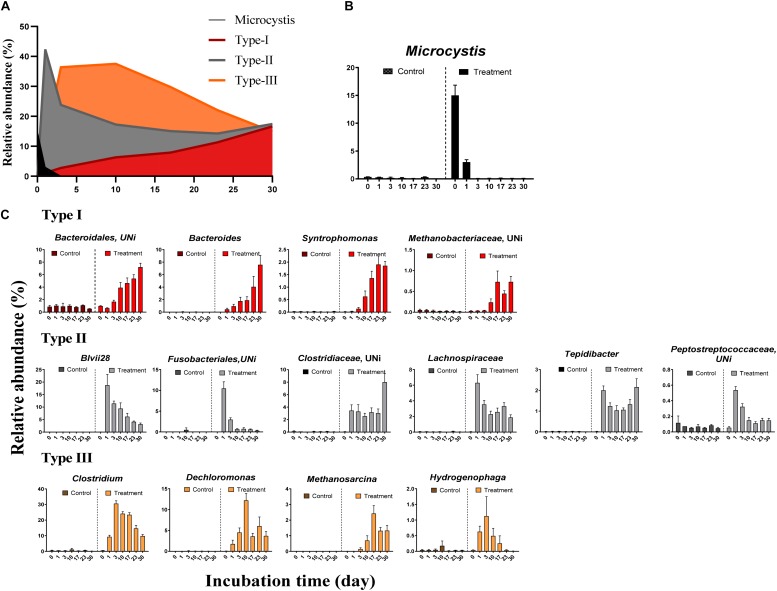
The relative abundance of Microcystis and three distinct microbial groups during the incubation. (A) The overview of relative abundance of Microcystis and three bacterial groups in Treatment samples; (B) the decay of Microcystis along the time; (C) variation of the relative abundance for representative genera in each group. The colors in subfigure of (C) are corresponding to those in panel (A).